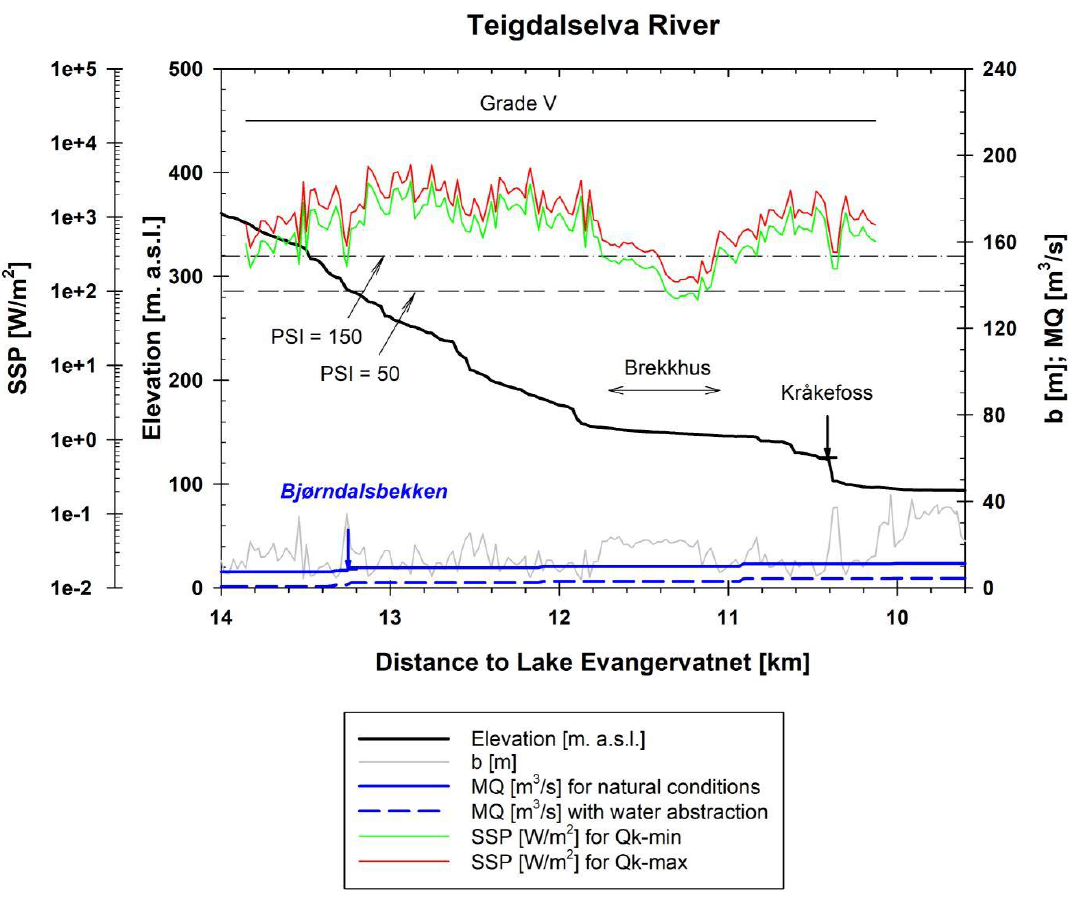
Figure 13. Longitudinal section of the grade V reach at Teigdalselva River. The following optimal kayak flow ranges are shown: upstream from Bjørndalsbekken 8–15 m 3 /s, downstream 15–25 m 3 /s. The longitudinal section for Strandelvi River highlights relatively low SSP values in the